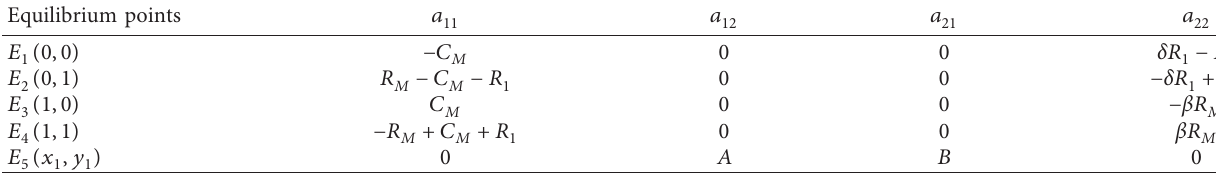
, a , a , and a at local equilibrium 11 12 21 22